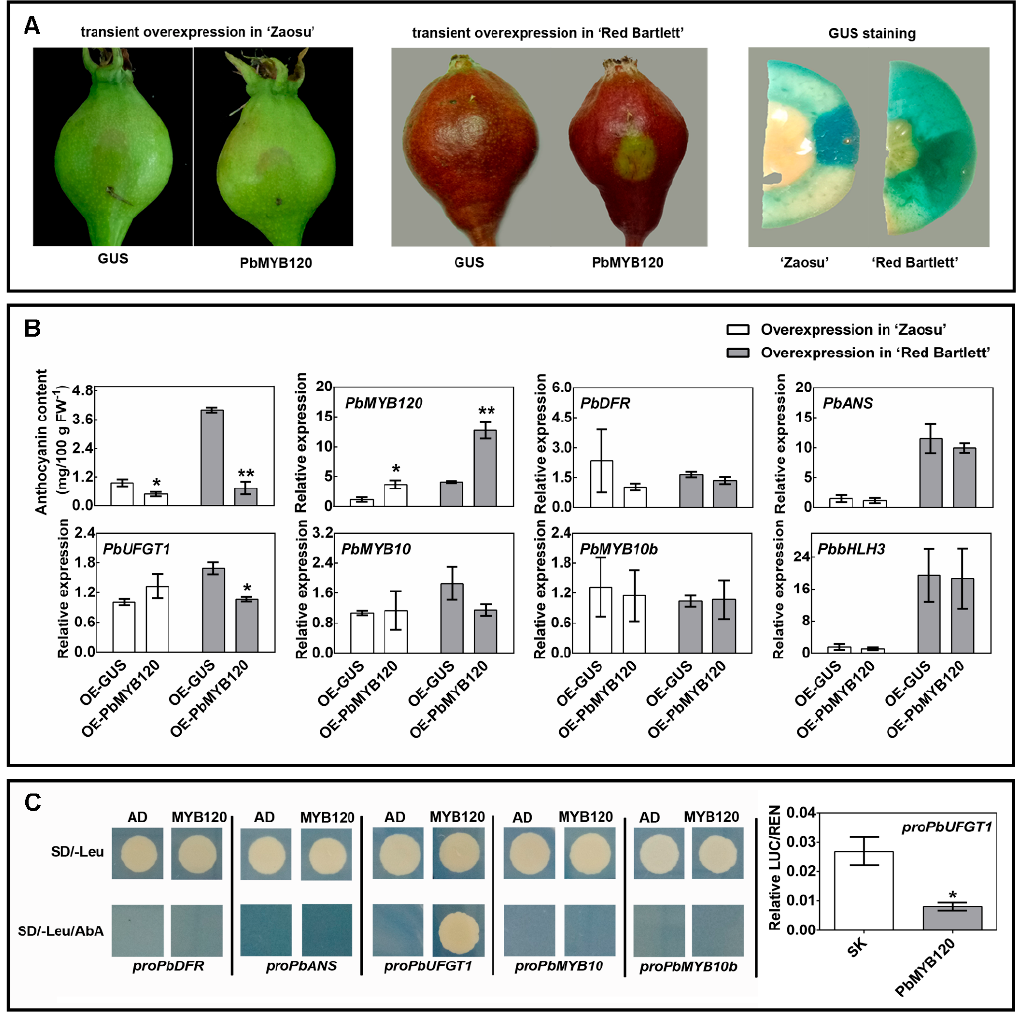
Figure 3. Transient overexpression and protein interaction analysis of PbMYB120. ( A ) Phenotypes of ‘Zaosu’ and ‘Red Bartlett’ fruit transiently overexpressing PbMYB120 and the determination of the transfection efficiency as assessed by GUS staining. ( B ) Analysis of anthocyanin biosynthesis and PbMYB120 expression in ‘Zaosu’ and ‘Red Bartlett’ fruit transiently overexpressing PbMYB120 . ( C ) Promoter-binding analyses of anthocyanin late biosynthetic genes (LBGs) and regulatory genes as assessed by Y1H assays, and a PbUFGT1 promoter activation analysis as assessed by the dual-luciferase reporter assay. Data are the means ± SEs of three biological replicates. Asterisks indicate significant differences as assessed by Student’s t test: * p < 0.05, ** p < 0.01.